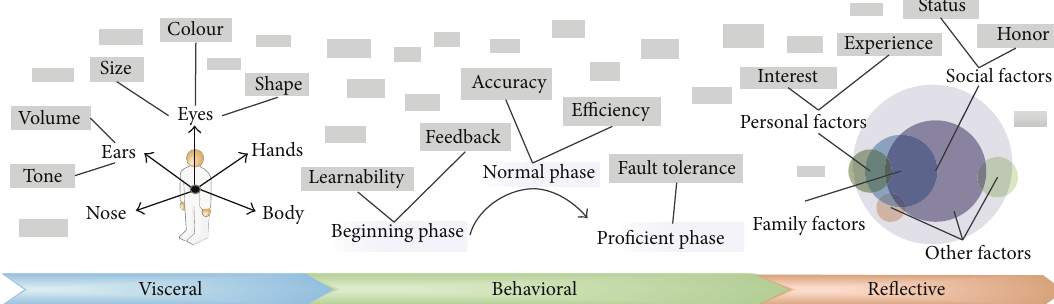
Figure 4: Extended strategy of topology structure of customer